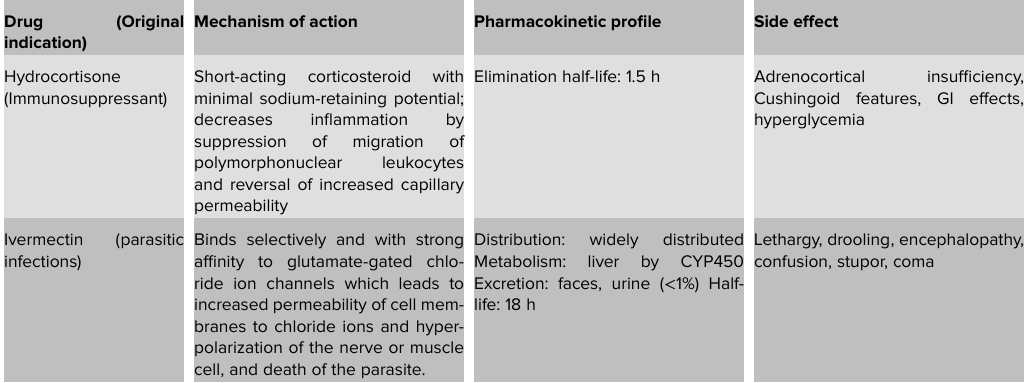
Table 3: Pharmacology of clinically repurposed drugs to treat COVID-19 [100,